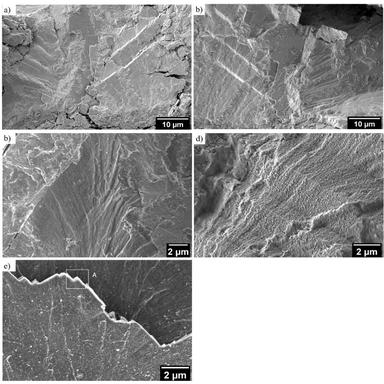
SE images from the fracture surface of an Alloy 690TT tube tested in a solution containing 5000 ppm of Pb: (a)-(b) low magnification images of matching fracture surfaces; (c) TG cleavage fracture, (d) 'step-like' features associated with TG fracture across twins. (e) Top view of a crystallographic step conjoining two parallel cracking planes. Note that for all images SCC propagation was bottom to top.